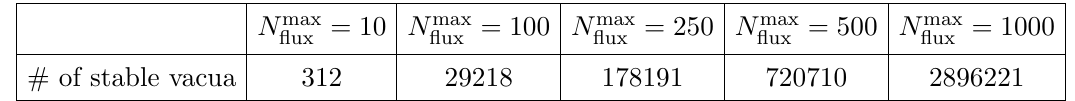
Table 1 . Number of stable vacua for each N max tadpole cancellation condition